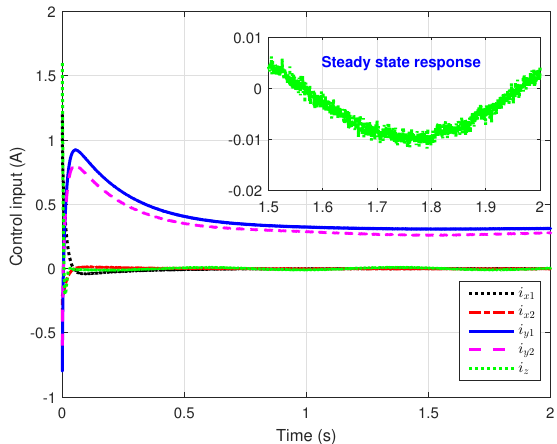
Figure 9. Time response of control inputs using PID.